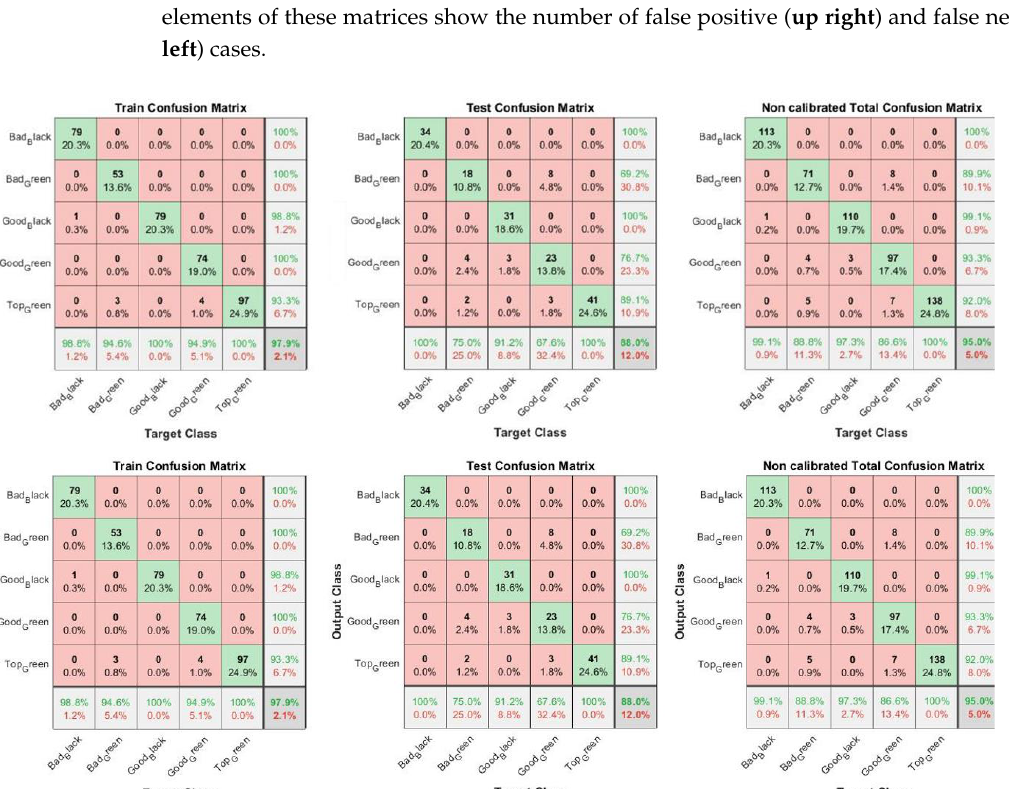
Figure 6. Confusion matrices for training, test and overall non-calibrated data sets. The off-diagonal elements of these matrices show the number of false positive ( up right ) and false negative ( down left ) cases.